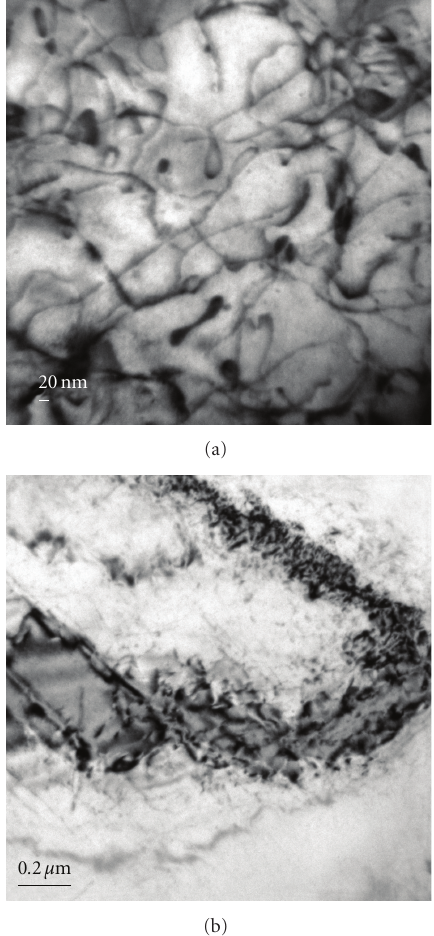
Figure 8: TEM micrographs of Al-SiC